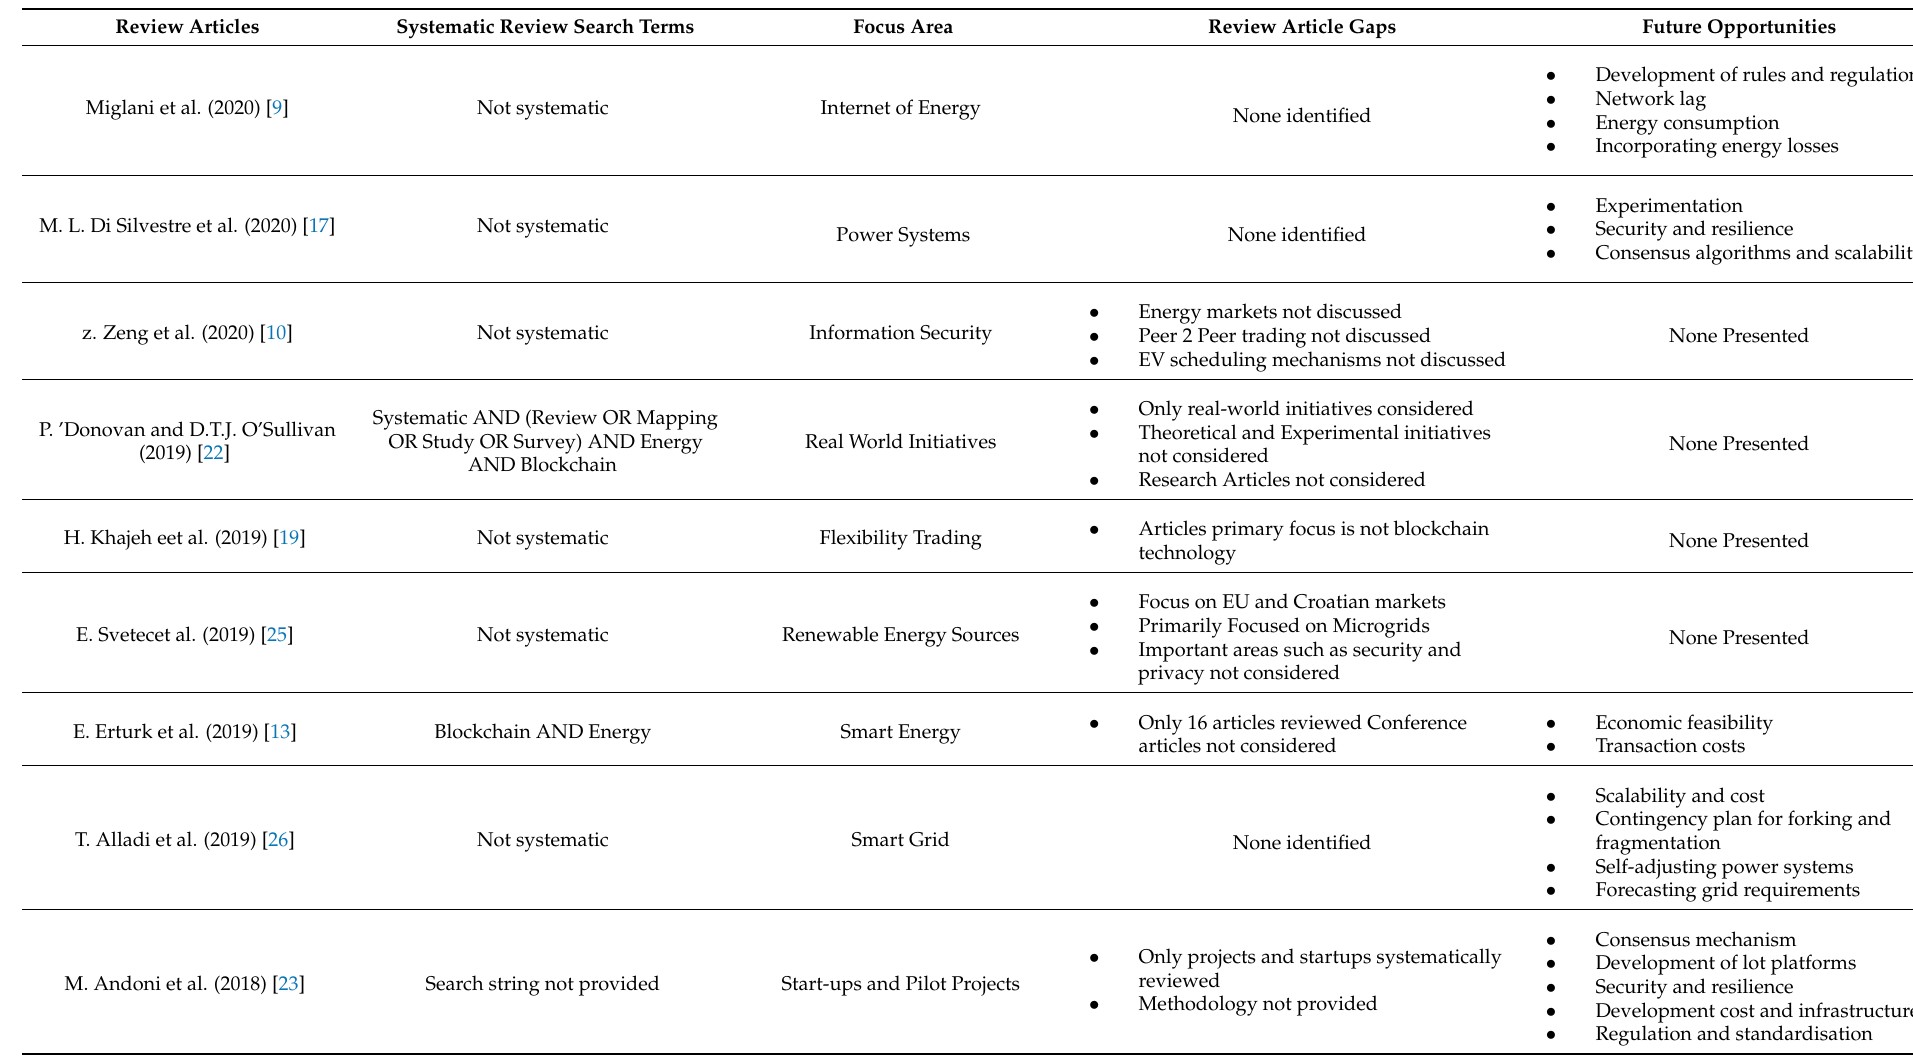
Table 1. Analysis of reviews of blockchain applications for the energy